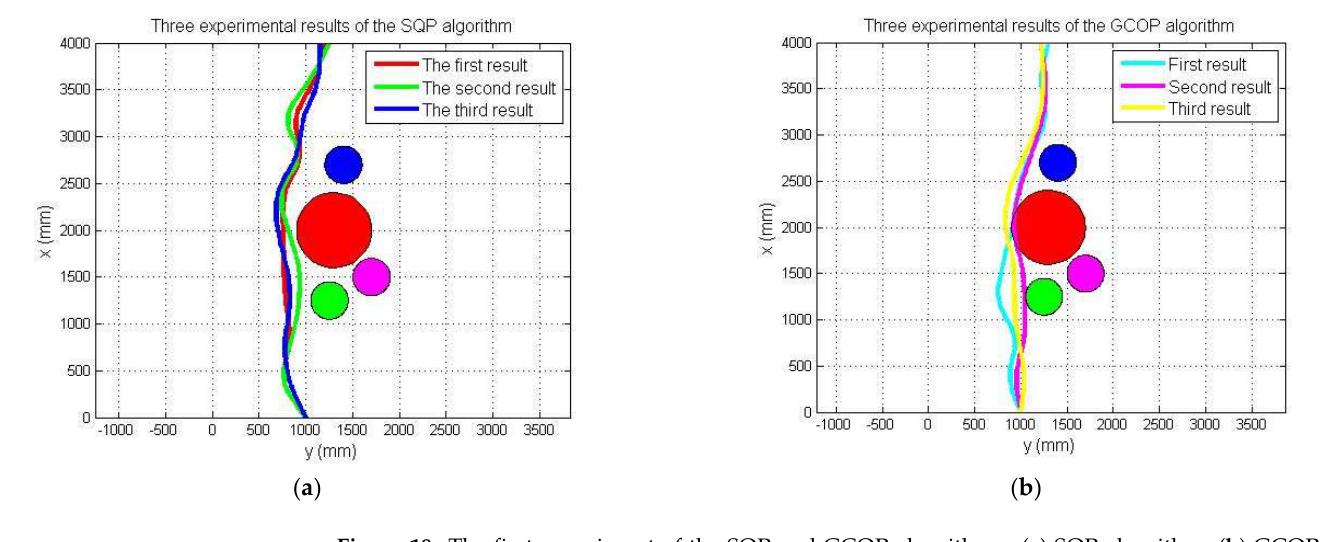
Figure 18. The first experiment of the SQP and GCOP algorithms. ( a ) SOP algorithm; ( b ) GCOP algorithm (the red ball represents an obstacle with a diameter = 500 mm and other balls represents an obstacle with a diameter = 200 mm).